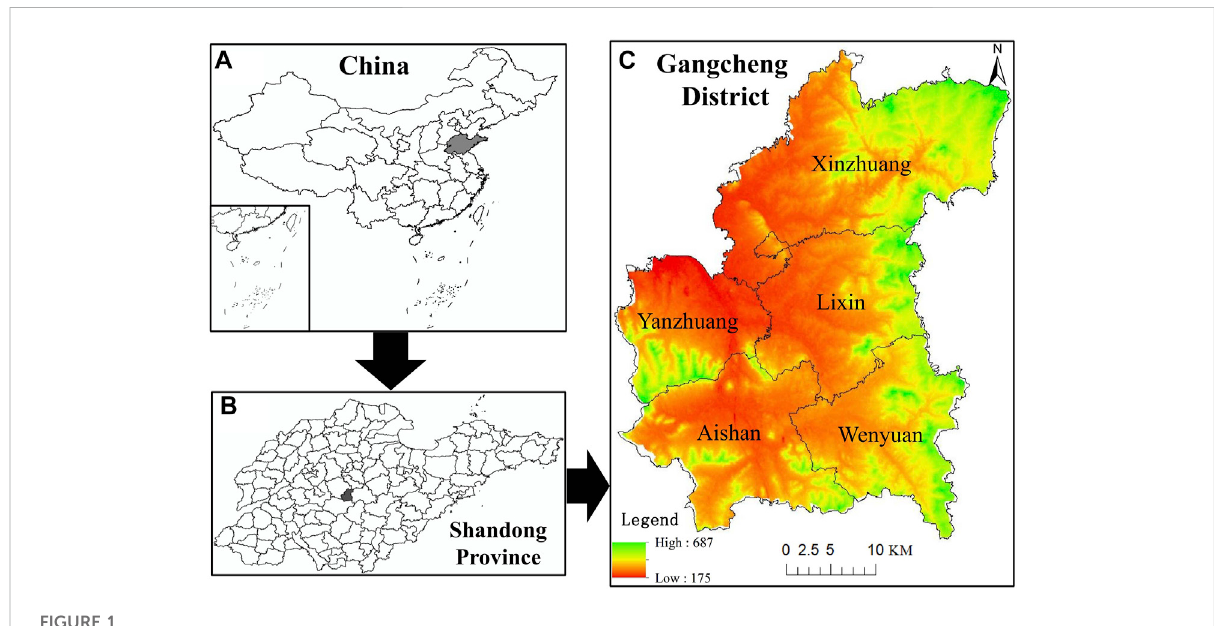
FIGURE 1 Location of the study